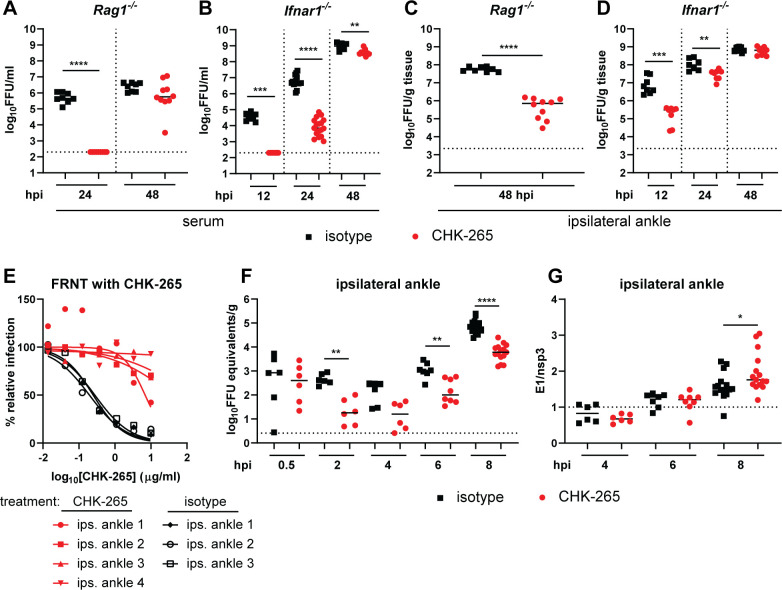
The reduced RRV infection by CHK-265 at the site of inoculation requires type I IFN signaling.Four-week-old male and female Rag1-/- (A, C), Ifnar1-/- (B, D-E), or WT (F, G) C57BL/6 mice were administered 100 μg of CHK-265 prior to infection with 103 FFU of RRV. (A-B) Serum and (C-D) ipsilateral ankles were harvested at indicated time points and titered by FFA. Bars indicate median values [(A, C) n = 8–10 per group; three experiments; (B, D) n = 7–17 per group; two experiments; Mann-Whitney test; **P < 0.01, ***P < 0.001, ****P < 0.0001]. (E) Neutralization assay. CHK-265 was preincubated with 102 FFU of RRV derived from the ipsilateral ankle collected from CHK-265 or isotype-treated Ifnar1-/- mice at 2 dpi and then added to Vero cells for 20 h. Viral foci were counted and compared to wells without mAb to determine relative infection. (F-G) Ipsilateral ankles were harvested at indicated time points and (F) viral RNA was titered by qRT-PCR for the nsp3 gene. (G) RRV E1 and nsp3 genes were quantified by qRT-PCR and the ratio of structural (E1)/ non-structural (nsp3) genes were plotted as an indirect measure of active viral infection. (F-G) Bars indicate median (n = 6–15 per group; two to five experiments; Mann-Whitney test; *P < 0.05, **P < 0.01, ****P < 0.0001).